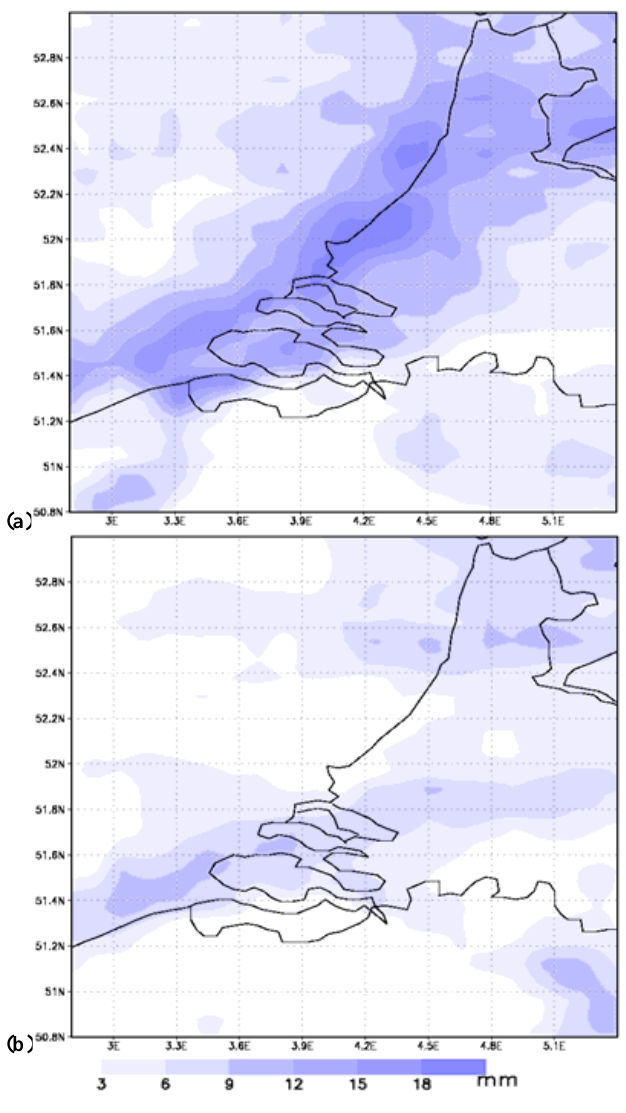
Fig. 14. Accumulated precipitation amounts (mm), produced by simulation 13 (a) and 14 (b) over the time period between 12 August 2004 12:00 UTC and 13 August 2004 12:00 UTC. Specifications of the simulations are written in Table